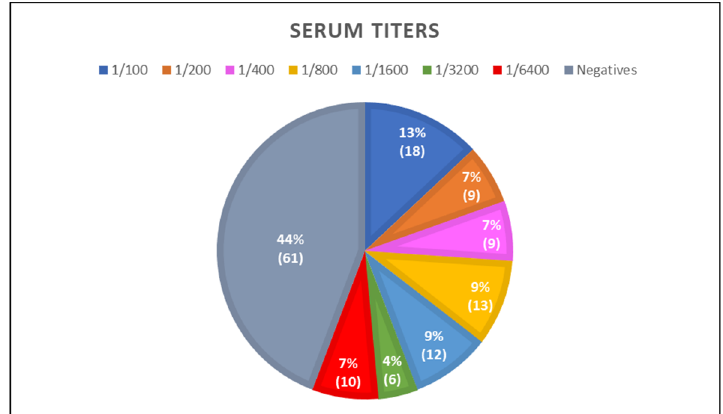
Figure 2. Distribution of anti- E. cuniculi serum titers by IFAT.